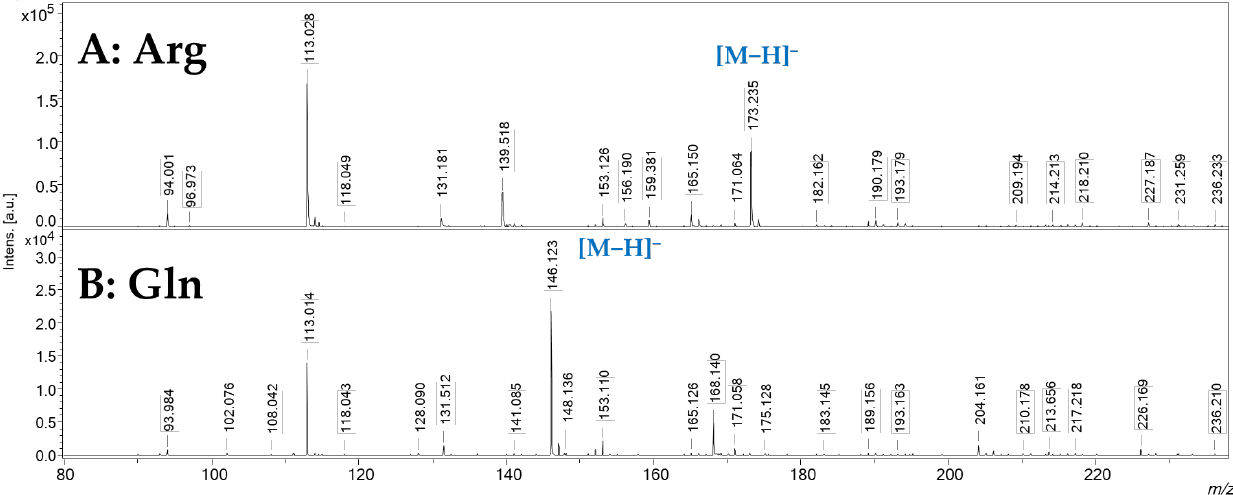
Figure 7. SALDI-MS spectra obtained in negative ionization mode for the analysis of panel ( A ): arginine (Arg, water solution, 1 mg/mL) and panel ( B ): glutamine (Gln, water solution, 1 mg/mL).